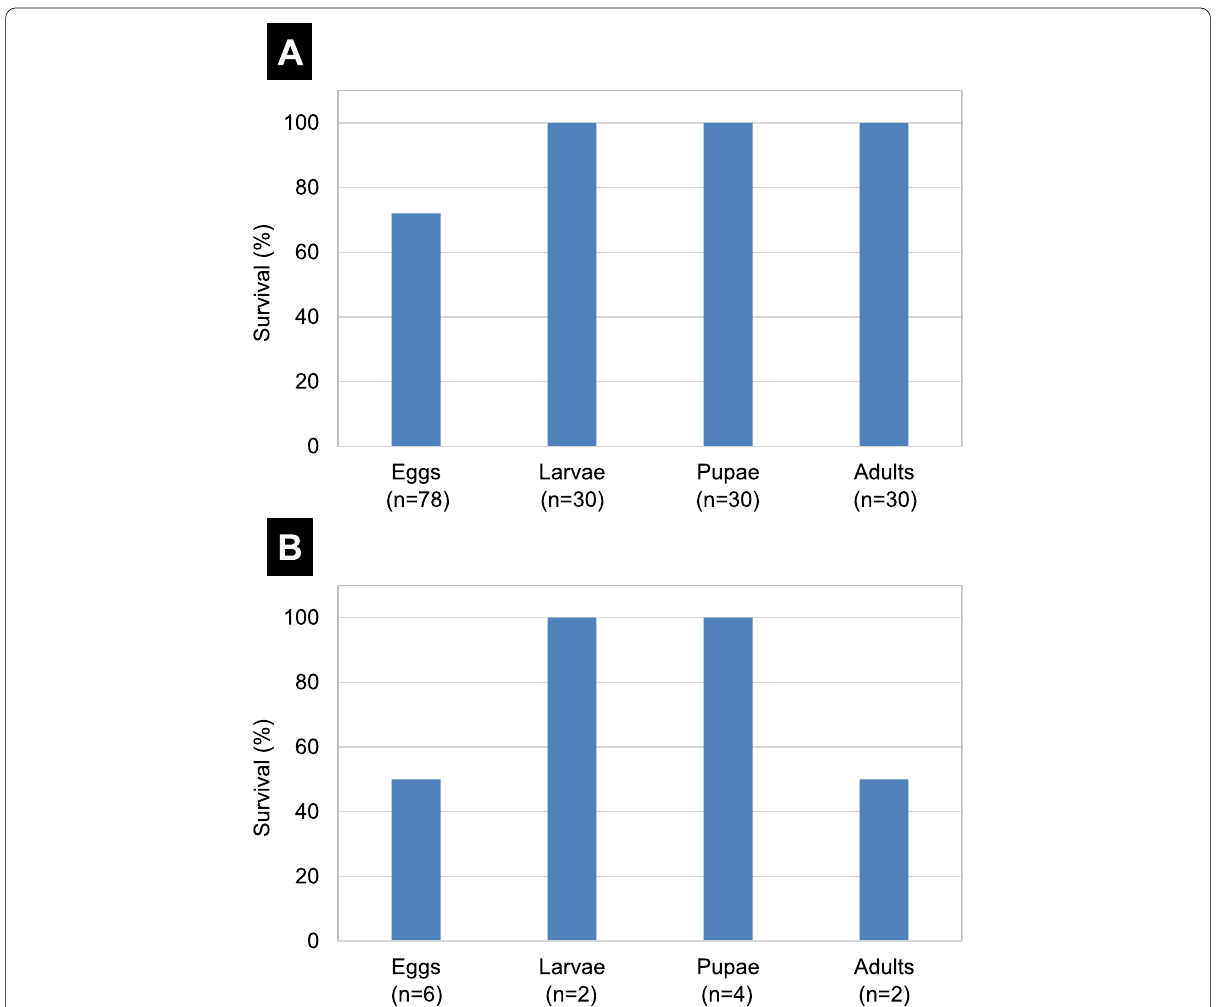
Fig. 1 Survival percentage of the confused flour beetle Tribolium confusum . A Survival after exposure to a pressure of 10 − 1 Pa in the SEM chamber for 30 min. B Survival after exposure to SEM observations for at least 2 min to 1 h (Pease et al.